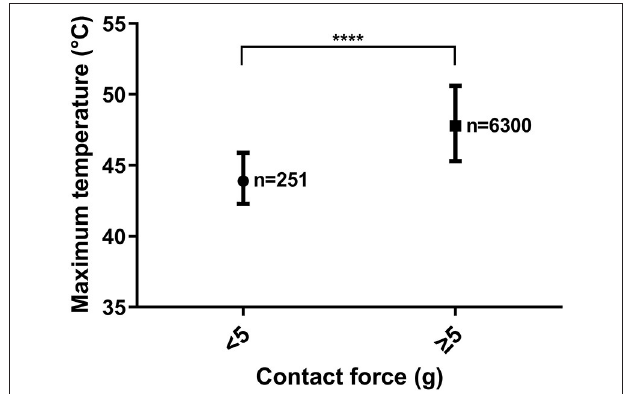
FIGURE 5 | Difference in the maximum temperature between lesions created with a CF < 5g and those with a CF ≥ 5g. **** = p < 0.0001. Median and interquartile ranges.